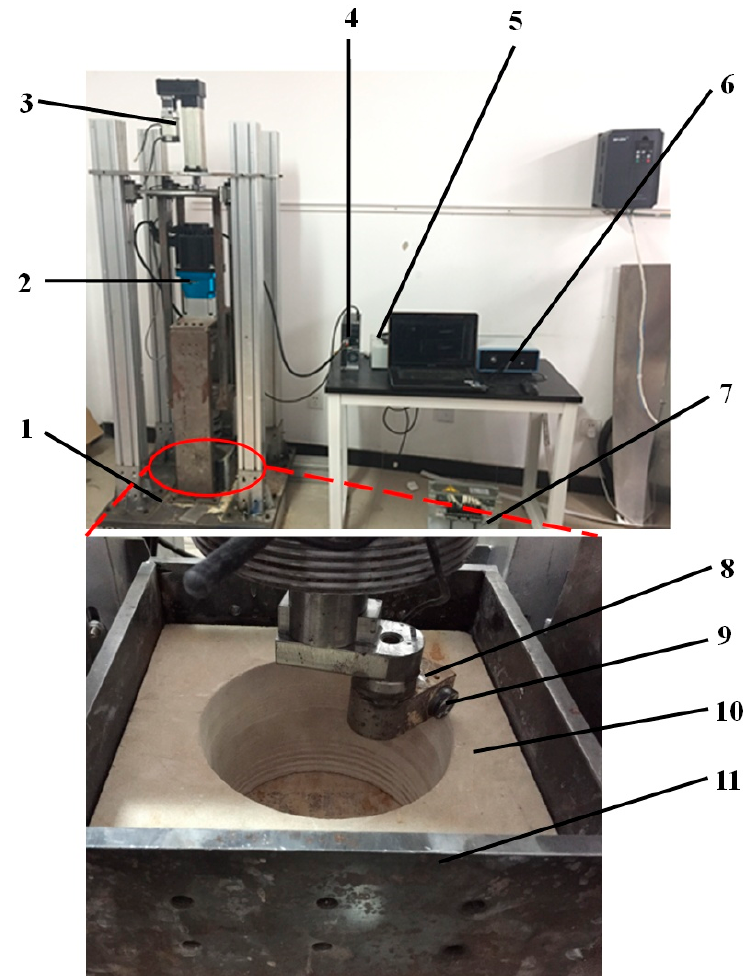
Figure 1. Rock cutting testing facility. 1–Base, 2–Motor, 3–Linear actuator, 4–Motor controller, 5–Actuator